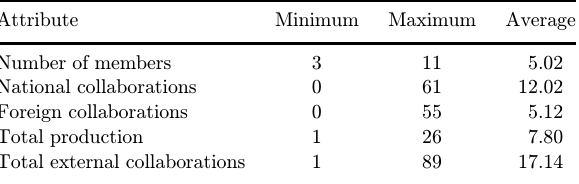
Table 6. Minimum, maximum and average values for academic bodies attributes.